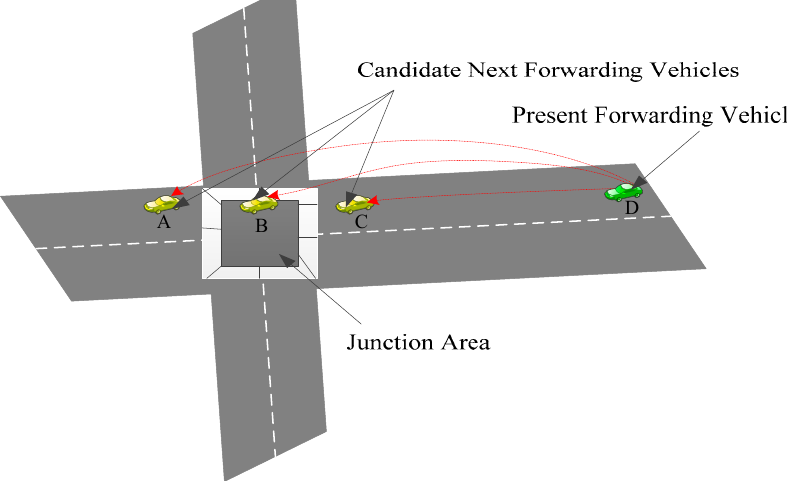
Figure 1. Candidate next forwarding vehicles in the junction area.